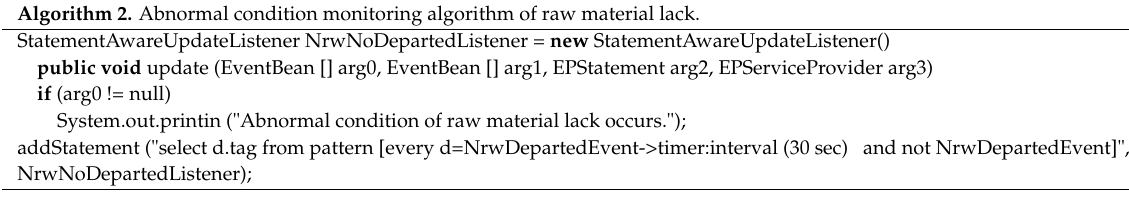
Algorithm 2. Abnormal condition monitoring algorithm of raw material lack.